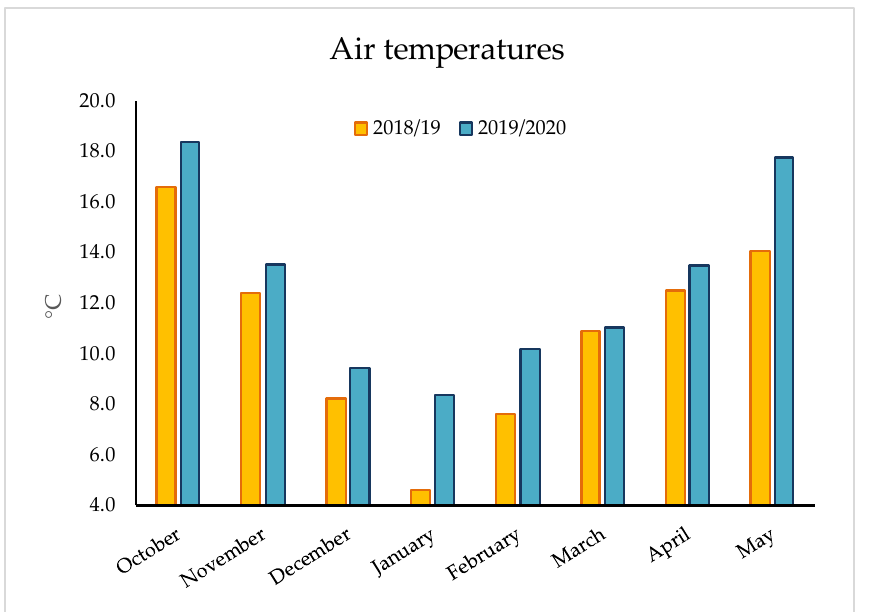
Figure 1. Mean monthly air temperatures from planting (October) to harvest end (May) in the 2018/19 and 2019/20 cropping seasons in Scanzano Jonico, Southern Italy. Data were obtained from a meteorological station located nearby the trial site belonging to the Basilicata Region (Centro Funzionale Decentrato (CFD), Regione Basilicata). Table 1. Total leaf area (LA, cm 2 · plant − 1 ) and dry weight (DW, g plant − 1 ) of cv. Sabrosa* plants developed under different soil pre-planting treatments in the 2018/2019 and 2019/2020 seasons in Scanzano Jonico, south of